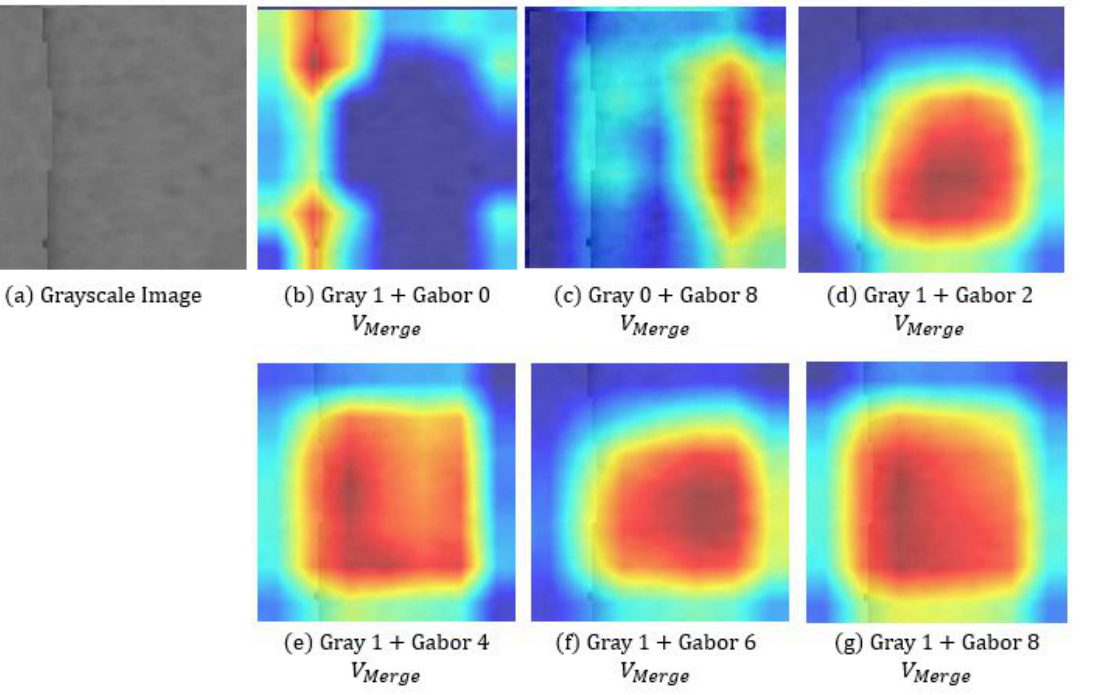
Figure 10. CAM image result for CCM OK image in a Single-stream Network.